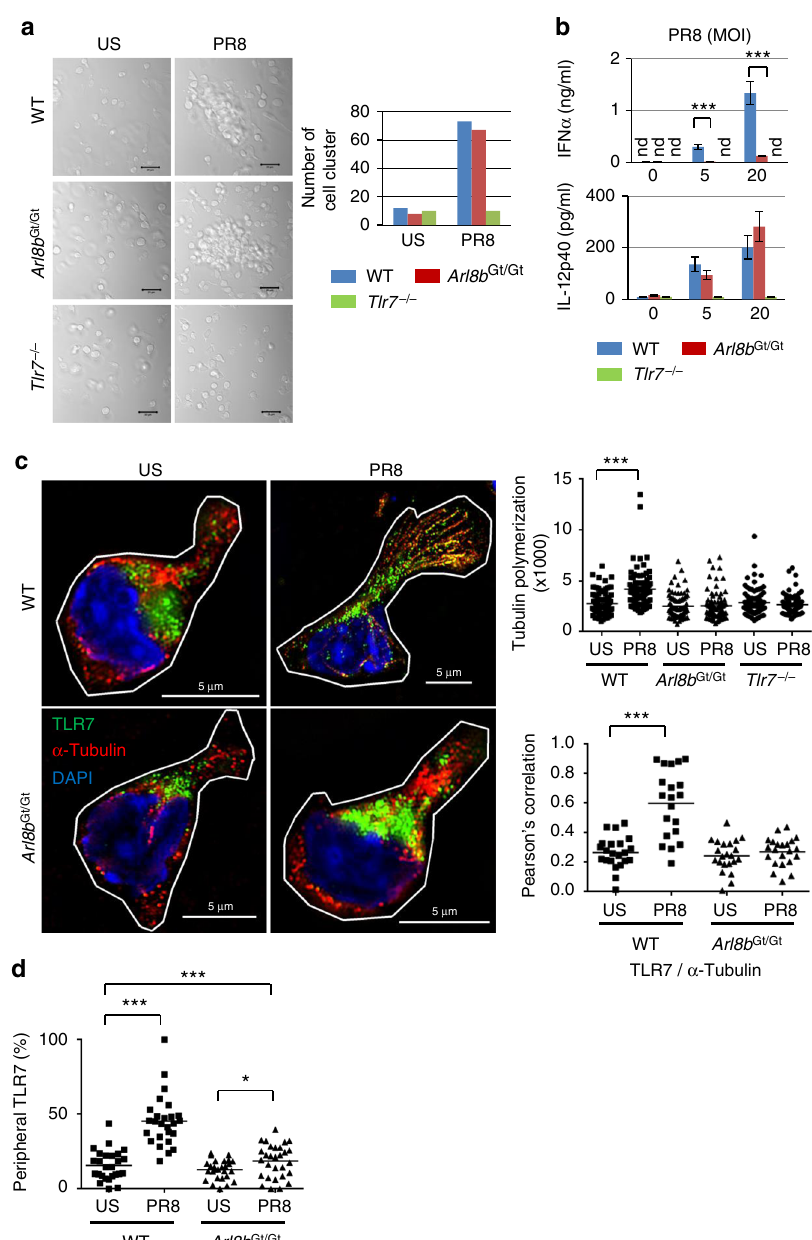
Fig. 5 Impaired TLR7 traf fi cking and defective IFN- α responses in in fl uenza virus-infected Arl8b Gt/Gt pDCs. WT, Arl8b Gt/Gt , or Tlr7 − / − pDCs were left unstimulated (US) or infected with in fl uenza virus PR8 (PR8) at 20 MOI ( a , c ) or at the indicated doses ( b ). After 5 h, pDC clustering was assessed by confocal microscopy and enumerated in 30 visual areas ( a ). The cells were immunolabeled using Abs against TLR7 (green), and α -tubulin (red), together with DAPI staining of cell nuclei (blue). Statistical determination of microtubule polymerization ( n > 84), TLR7 co-localization with α -tubulin ( n > 19), and TLR7 traf fi cking in each cell are also shown ( n > 25) ( c , d ). After 24h, cytokine production was determined by ELISA ( b ). Data are expressed as mean ± s.d. from triplicate wells. Similar experiments were repeated three times. Scale bar, 20 μ m ( a ), 5 μ m ( c ). *** P < 0.001 (unpaired two-tailed t